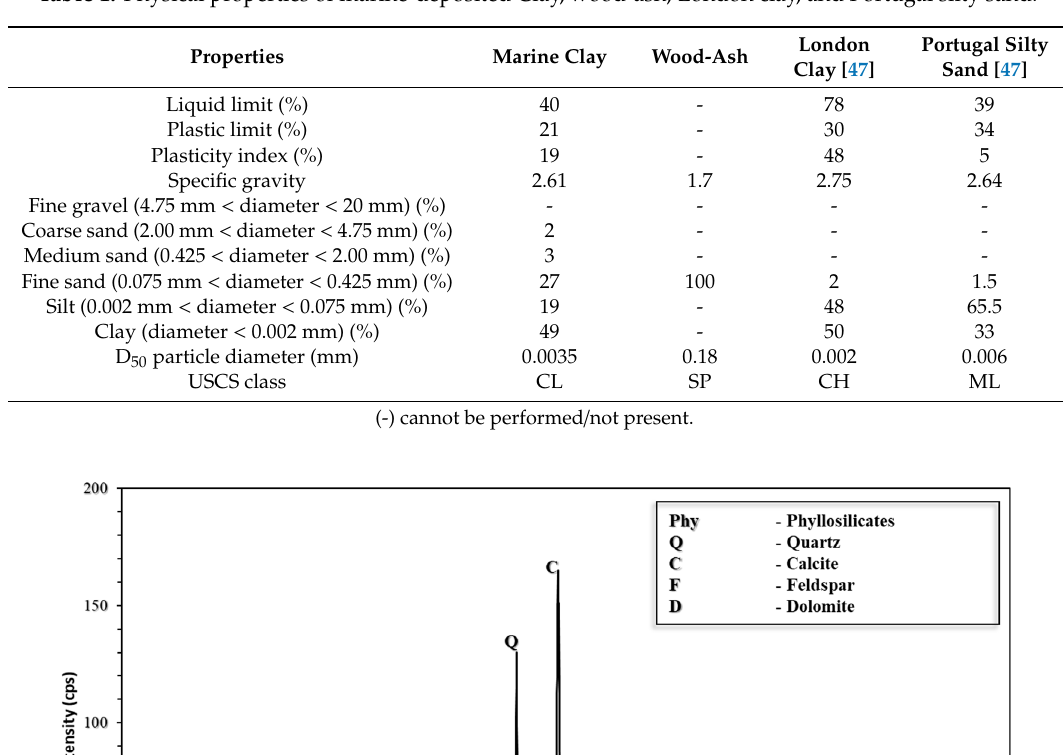
Figure 2. X-ray diffraction pattern of studied clay sample.